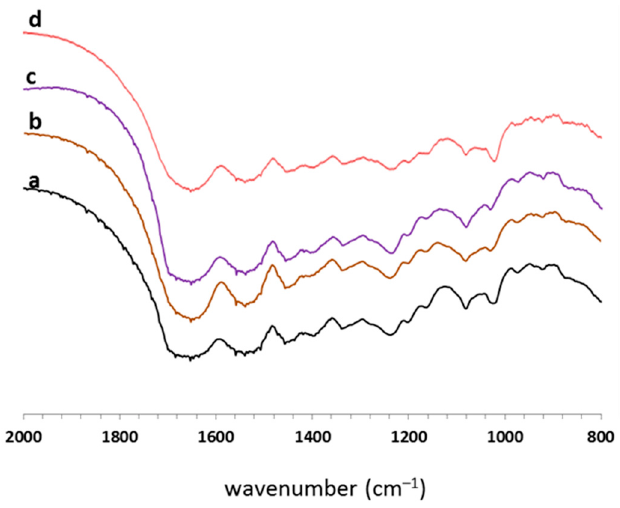
Figure 7. FT-IR spectra of gelatin fibers: ( a ) gelatin fibers without crosslinking; ( b ) GlcNAc- crosslinked fibers; ( c ) denacol-crosslinked fibers; and ( d ) GTA-treated fibers.